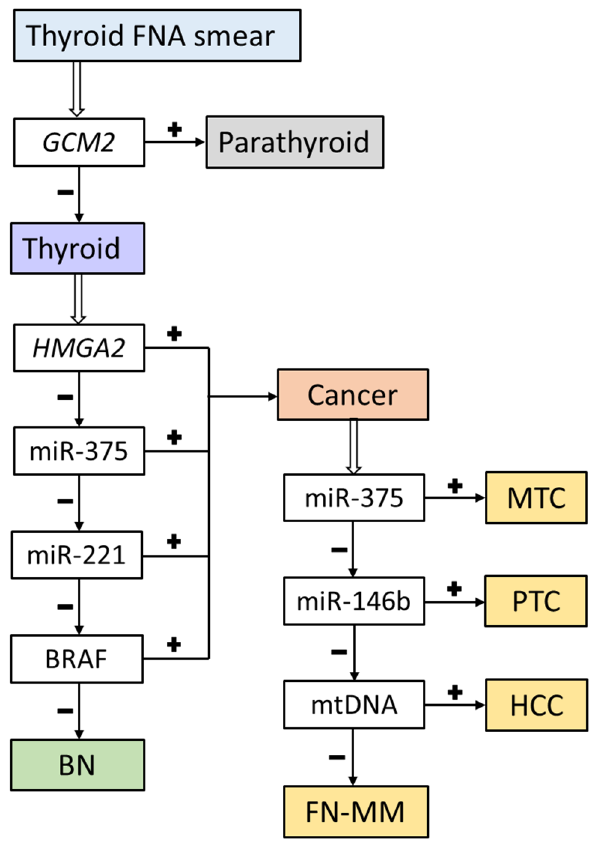
Figure 5. The decision tree for classifying samples into benign and malignant followed by cancer typing. +/−: exceeding the chosen cutoff or identifying the BRAF V600E mutation/not exceeding the chosen cutoff or not identifying the BRAF V600E mutation, BN: benign nodule, MTC: medullary thyroid carcinoma, PTC: papillary thyroid carcinoma, HCC: Hürthle cell thyroid carcinoma, FN-MM: follicular neoplasm with markers of malignancy.